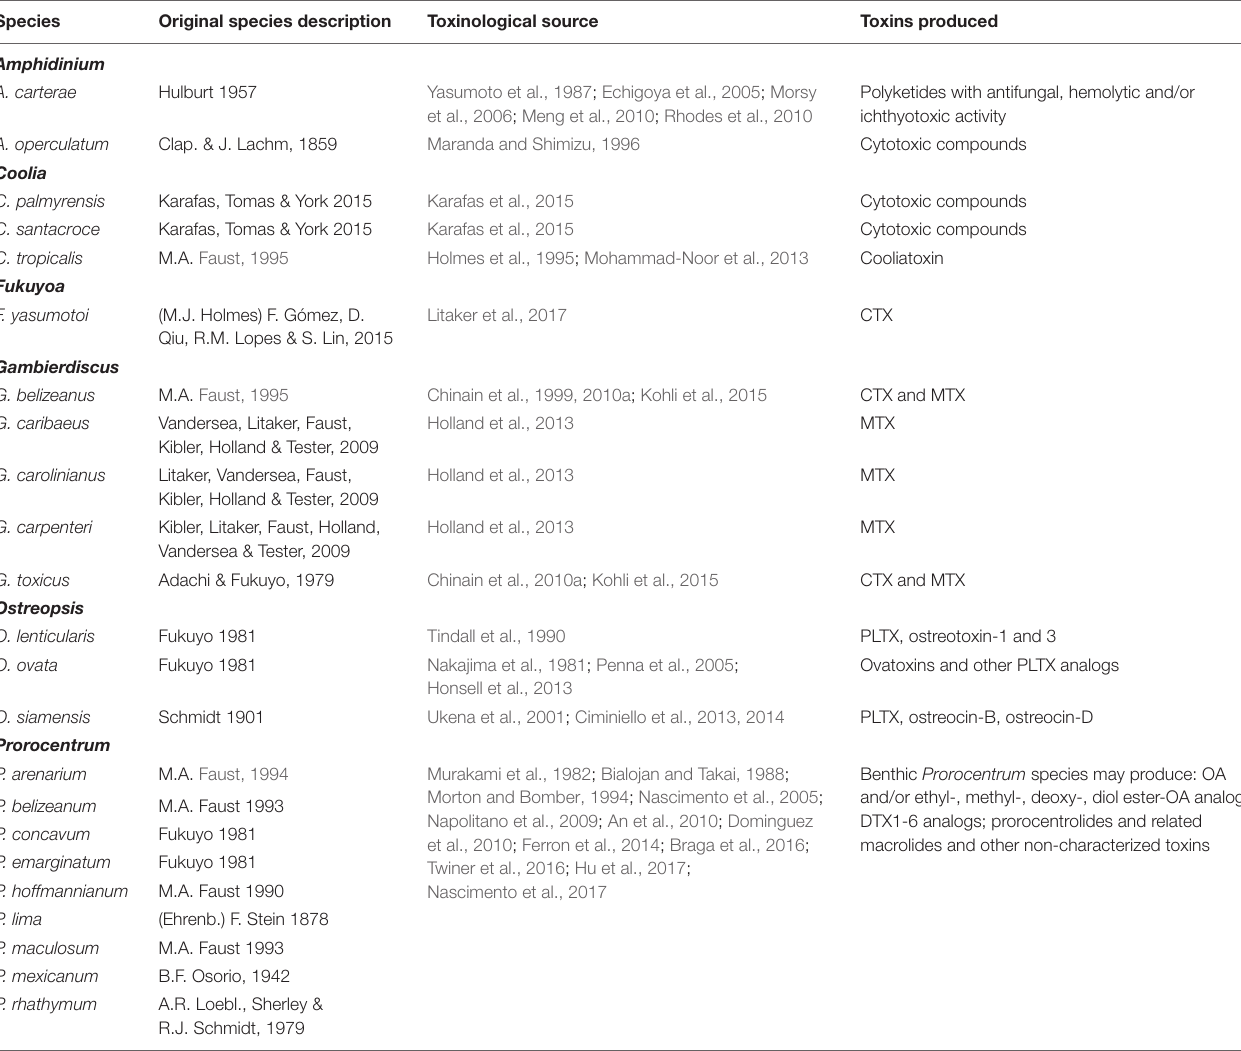
TABLE 2 | Toxic benthic dinoflagellates and evidence of